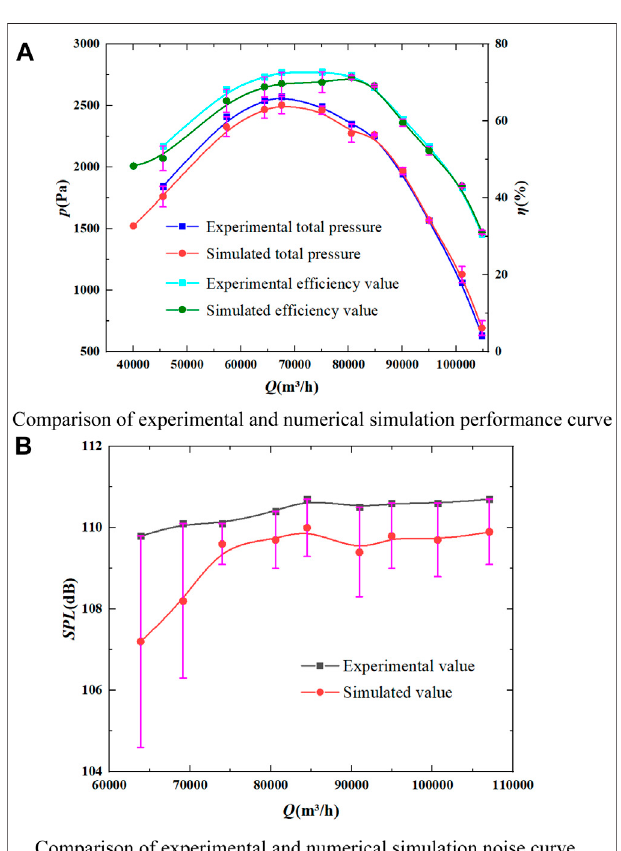
FIGURE 5 | Comparison of experimental and simulation results. (A) Comparison of experimental and numerical simulation performance curve (B) Comparison of experimental and numerical simulation noise